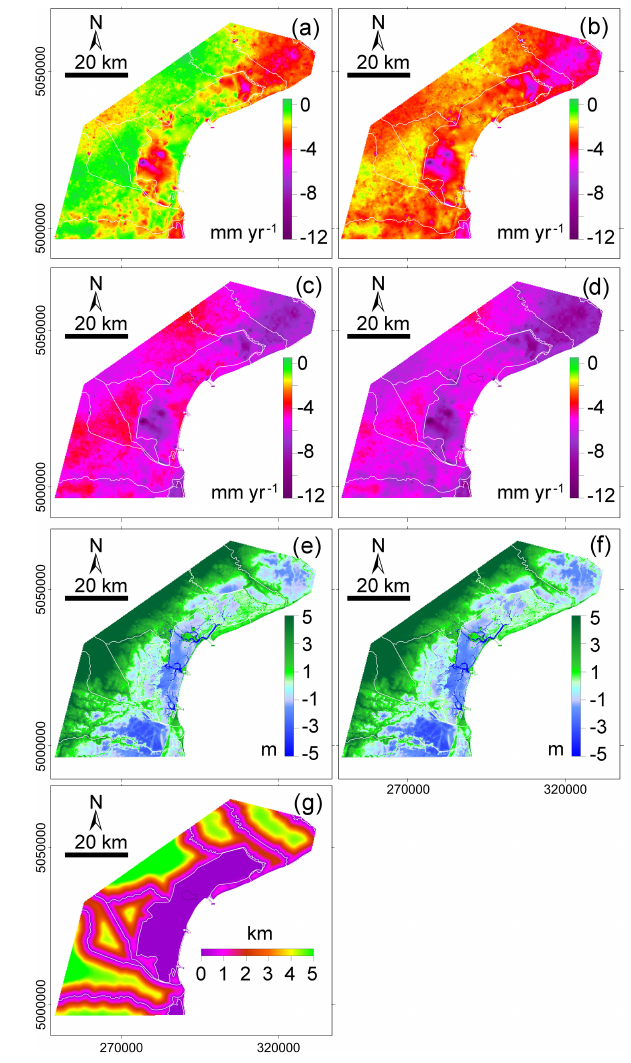
Figure 2. Thematic layers: (a) SUBS, (b) RSUBS – ongoing long- time series scenario, (c) RSUBS – ongoing short-time series sce- nario, (d) RSUBS – future scenario, (e) DEM, (f) DEM – future scenario, (g) WD.